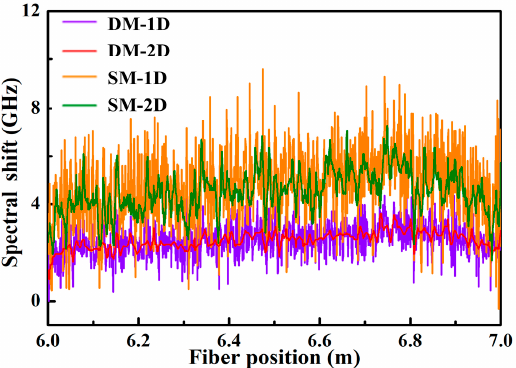
Figure 7. The variation of spectral shift obtained from the data processed by the DM-1D, DM-2D, SM-1D and SM-2D methods, represented by the pink, red, orange and green curves, respectively, when no temperature was applied.